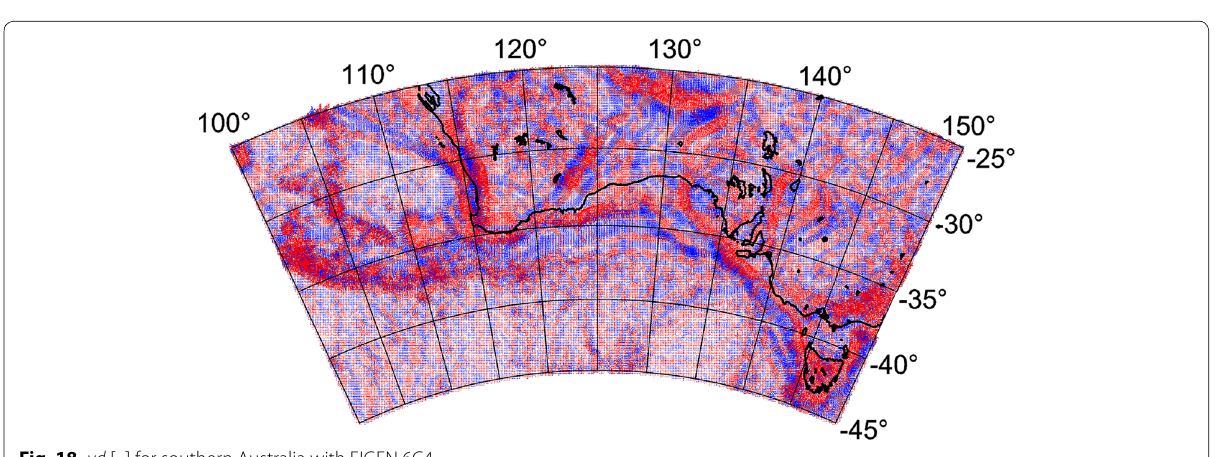
Fig. 18 vd [–] for southern Australia with EIGEN 6C4